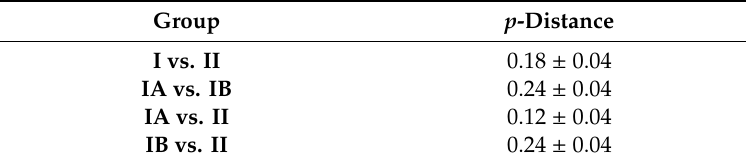
Table 7. Nucleotide sequence divergence ( p -distance) between Bov-B retrotransposon groups with outgroup